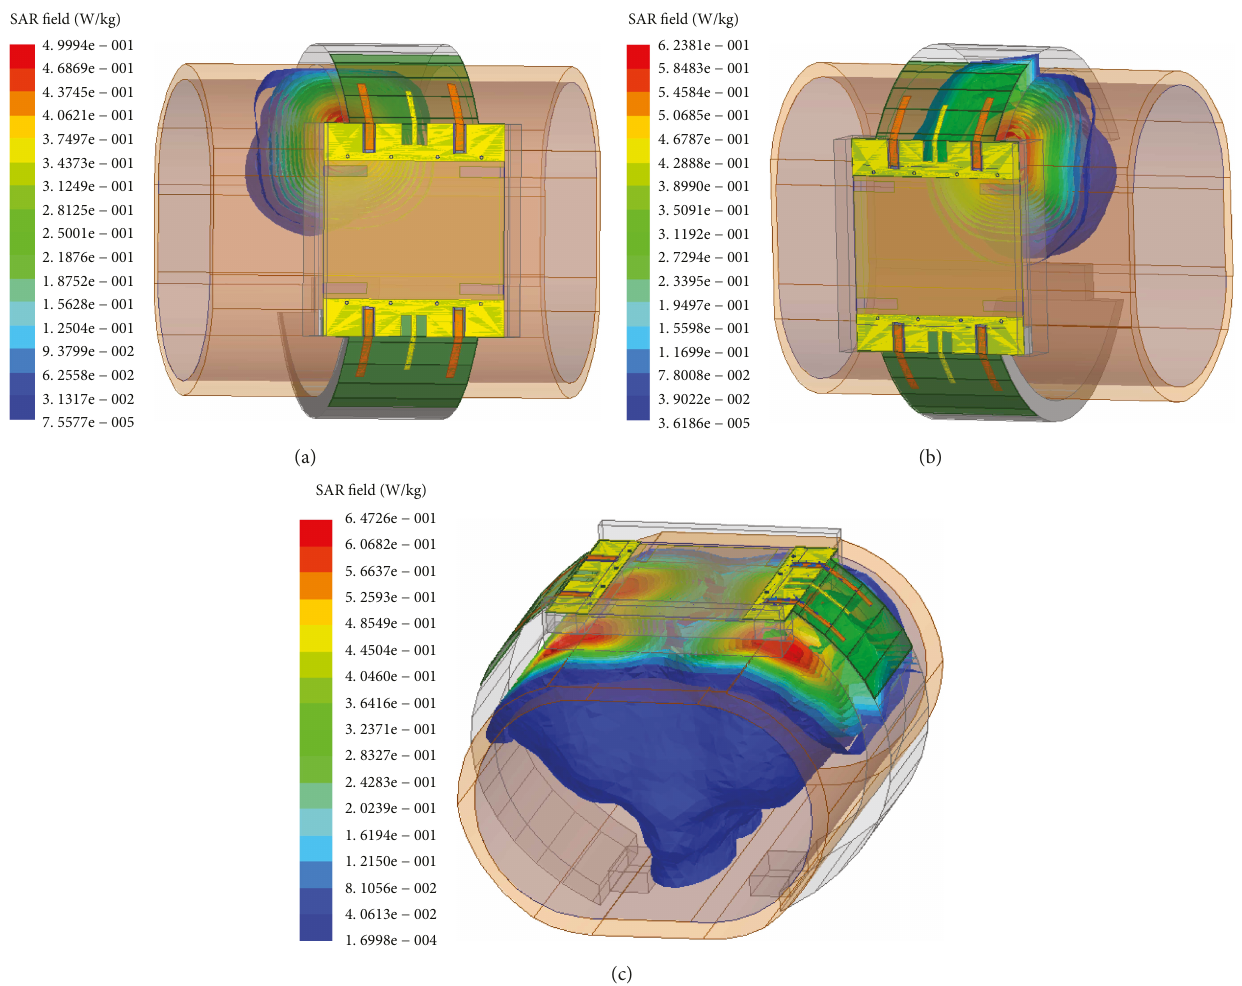
Figure 16: SAR simulation models worn on the wrist (a): Ant1 (b), Ant2 (c), and Ant1 – Ant4 (at